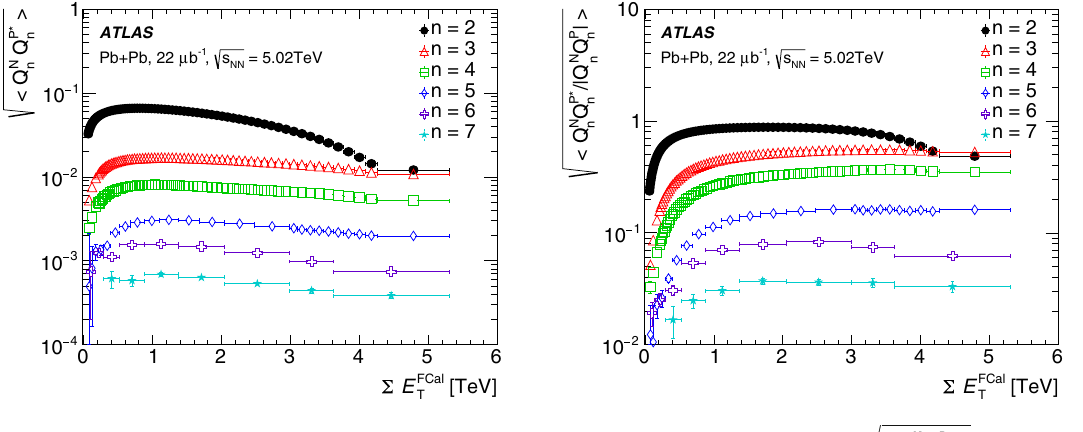
Fig. 4 The dependence of the correction factor in the SP method, measured harmonics as a function of (cid:8) E FCal